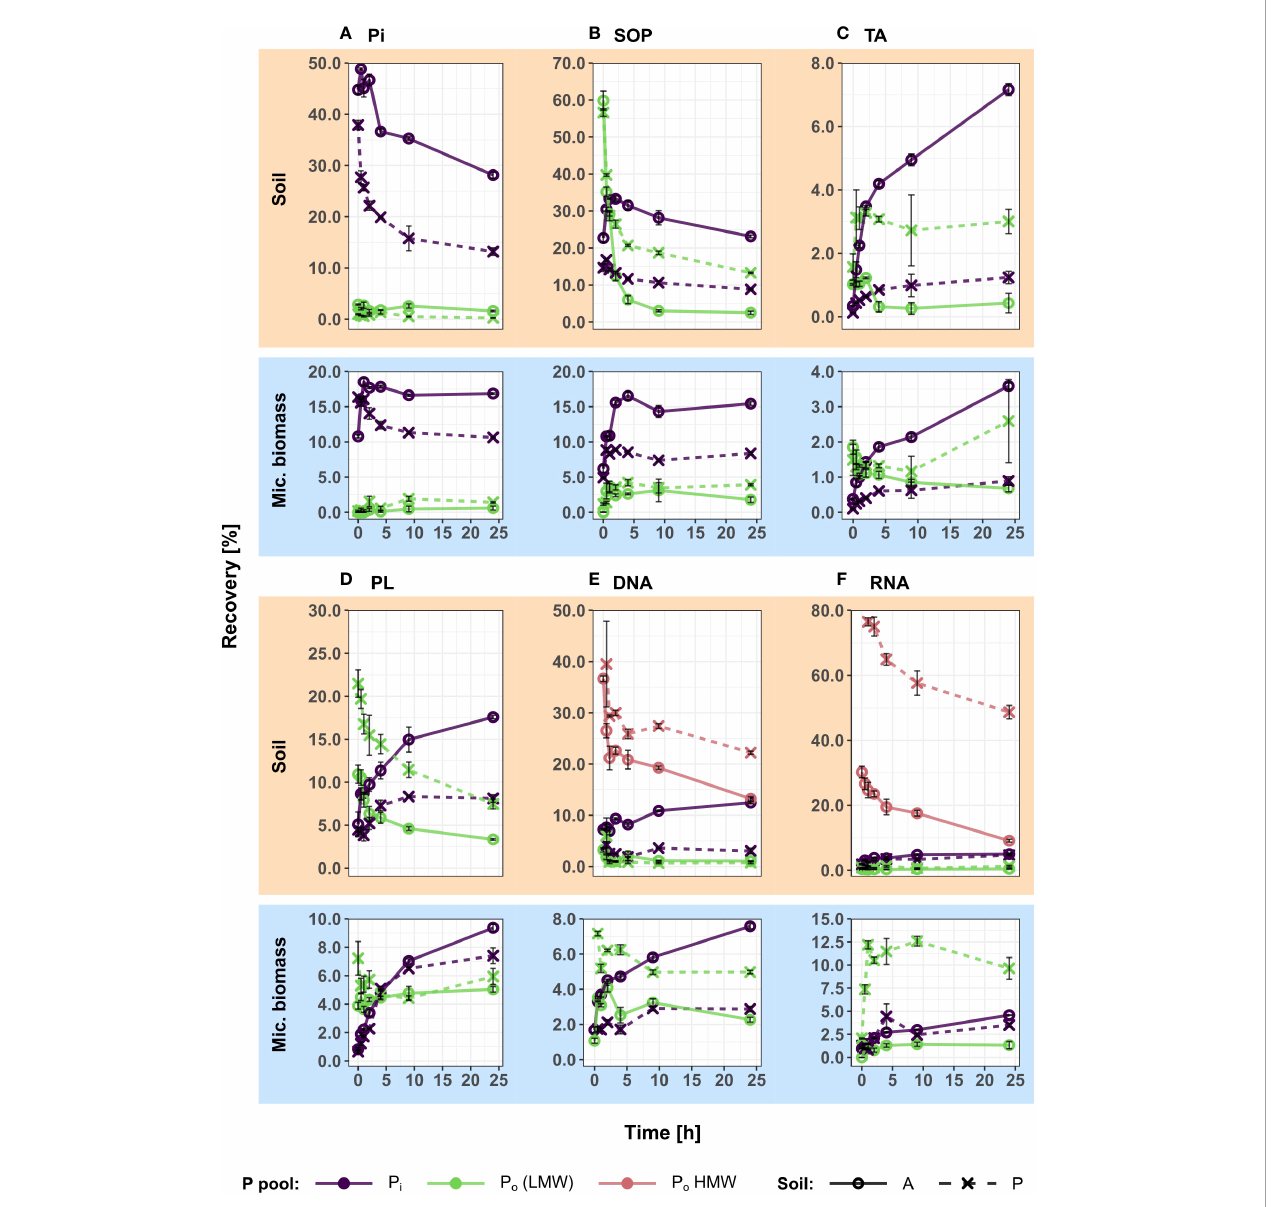
FIGURE 2 Recoveries of experimentally added 33 P in extractable soil and microbial organic (P o ) and inorganic (P i ) phosphorus pools over 24 h, showing the integrated temporal dynamics of decomposition processes, sorption and microbial P uptake for six different P compounds. 33 P recoveries (mean of triplicates ± S.E.) of all pools and time points are displayed as percentages of the initially added 33 P activity. In the nucleic acid treatments (E, F) , soil 33 P o is fractionated into low molecular weight (LMW) P o (<3kDa) and high molecular weight (HMW) P o (>3kDa) size classes. In all other treatments (A-D) , P o represents extracted P o , without size fractionation. In the case of TA (C) and PL (D) additions, extractable P o does not represent the intact added substrates (which are unextractable), but organic break down products. In the case of P o additions (B-F) , microbial 33 P o recovery was corrected for cell internal biosynthesis of P o , as described in detail in the methods section. Pi, inorganic phosphate; TA, cell wall teichoic acids; PL, phospholipids; SOP, soluble